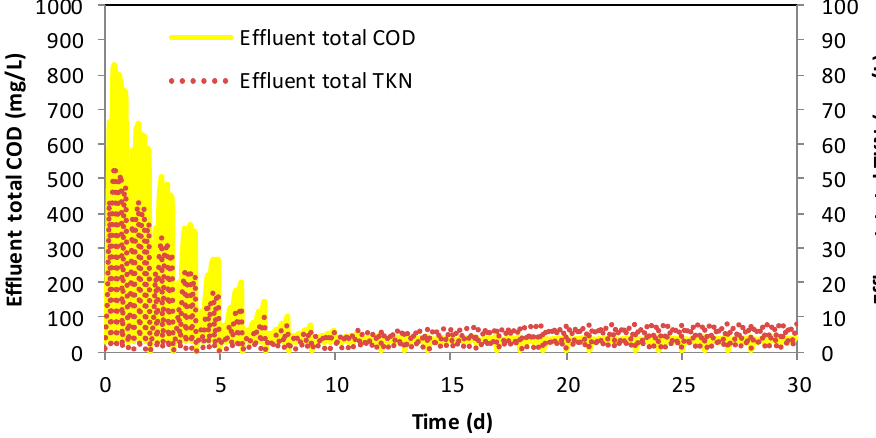
for the PRWWTPs containing SBR + CAS Figure 4. Evolution of the total COD and total TKN of the final effluent during the 30 days of